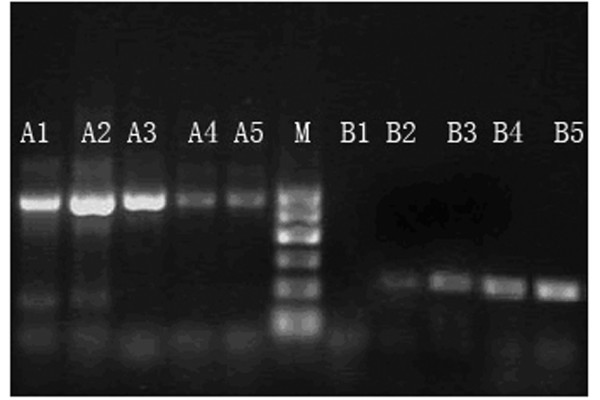
Expression of cFLIP (226 bp, B-lanes) and β-actin (540 bp, A-lanes) mRNA. M = Marker, B1 = Normal cervical tissues group, B2–5 respectively express CIN I, II, III and cervical squamous cell carcinoma groups.